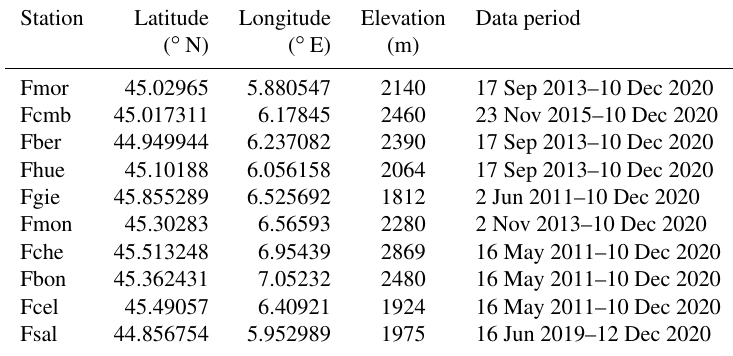
Table 1. List of stations used in this study.